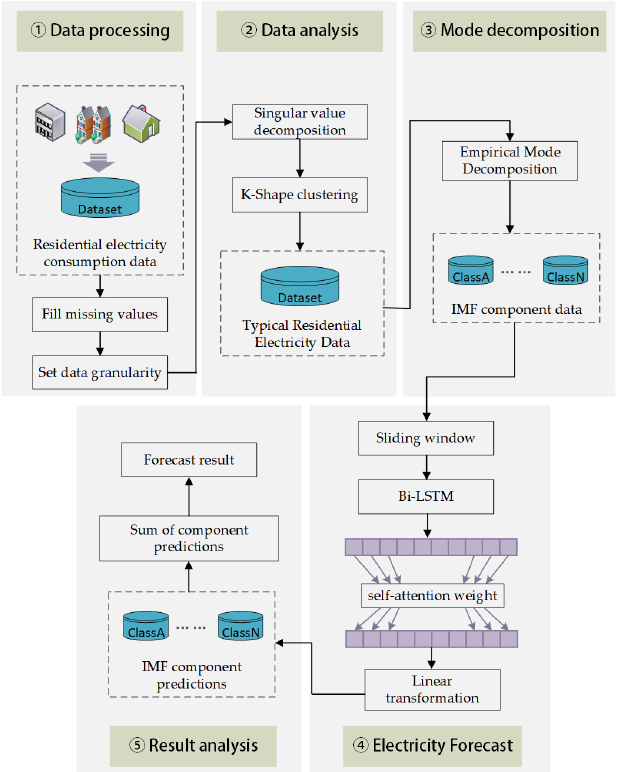
Figure 1. The framework of the daily load forecasting method.